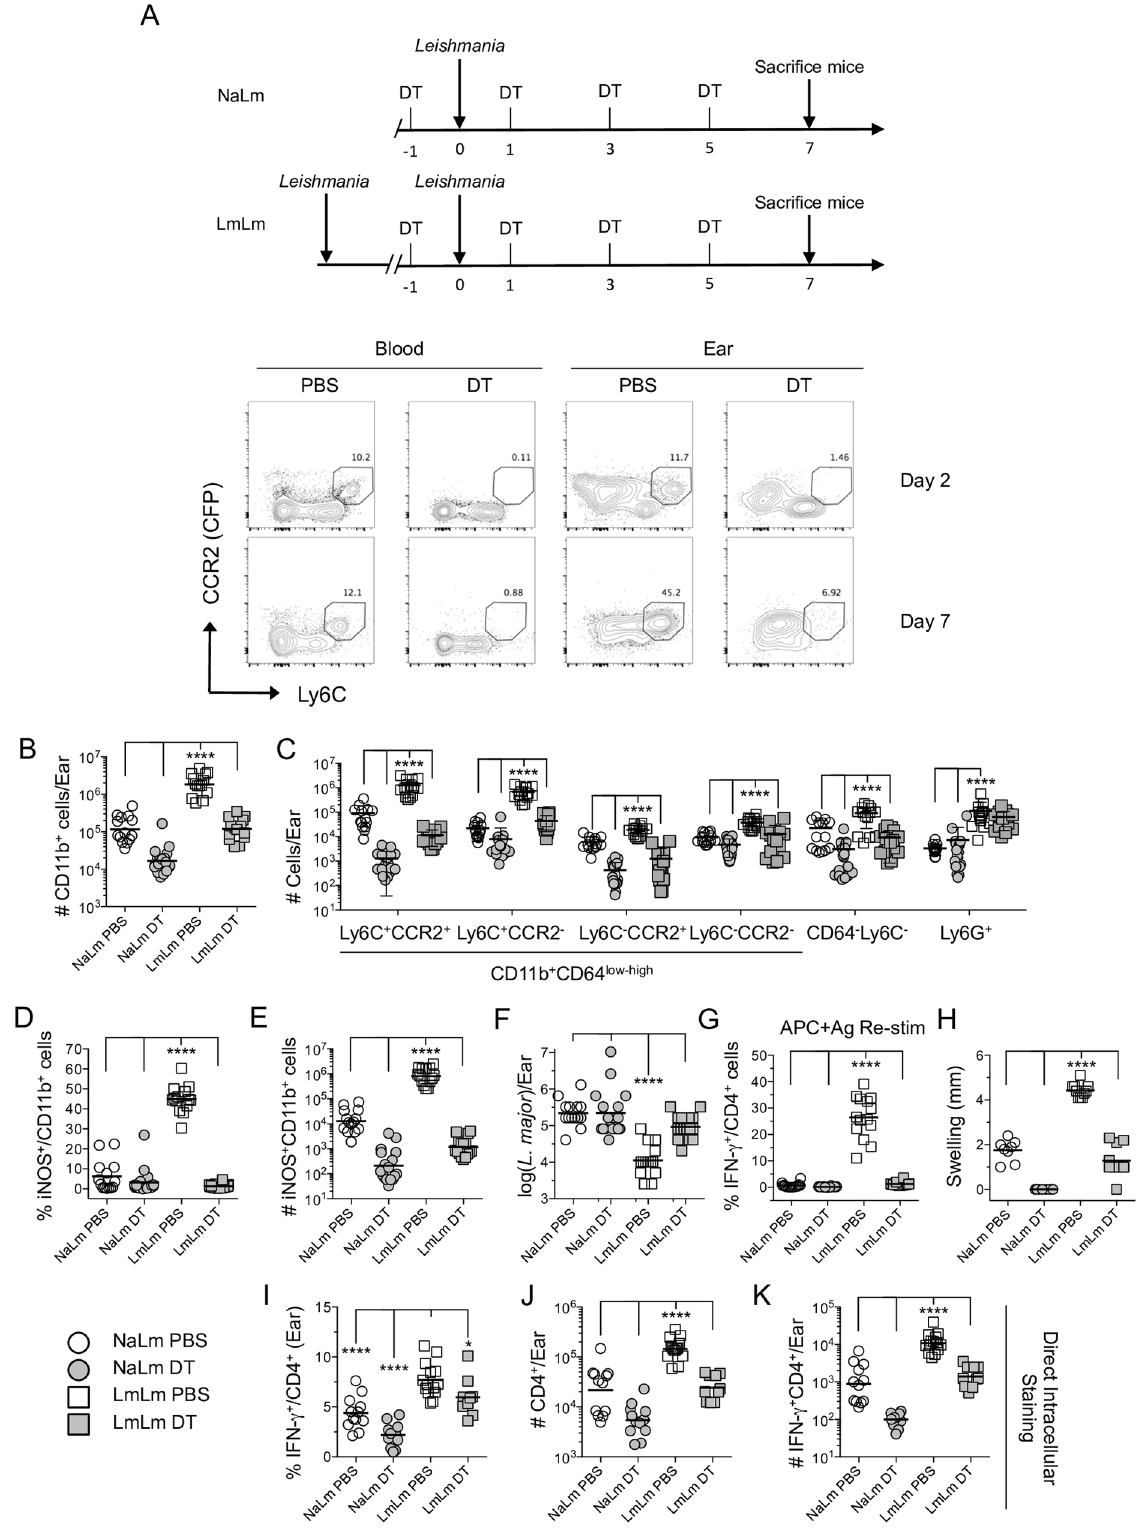
Fig 7. CCR2 + Monocytes are the effector cell responsible for parasite elimination at sites of secondary challenge. C57BL/6 CCR2.CFP-DTR ‘depleter’mice that were uninfectedor had a healedprimary infectionwere treated with PBS or DT prior to